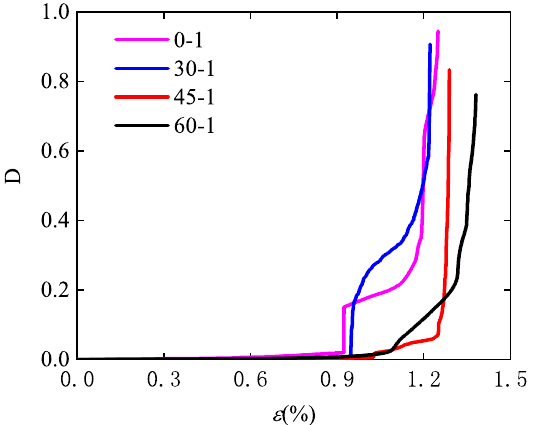
Figure 10. Damage evolution with loading for the specimen No. 0-1, No. 30-1, No. 45-1, and No. 60-1.